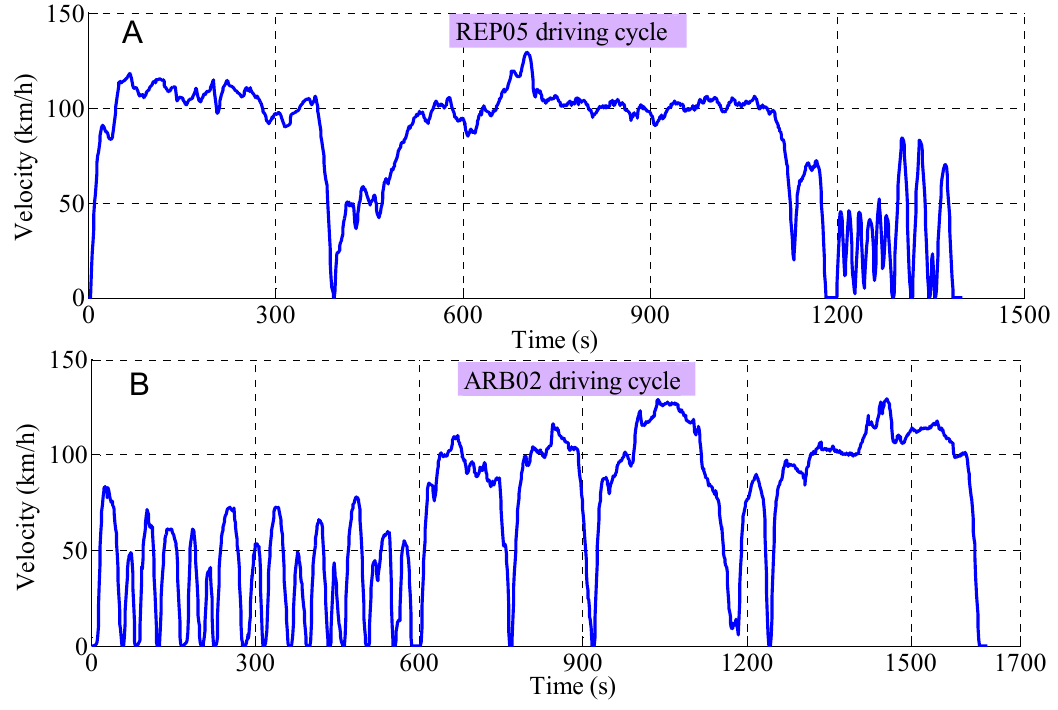
Figure 6. Test driving cycles: ( A ) Profiles of REP05; ( B ) Profiles of